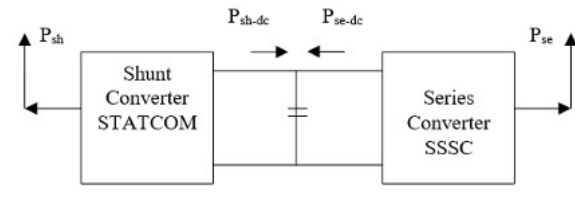
Figure 7. Power Balance of UPFC